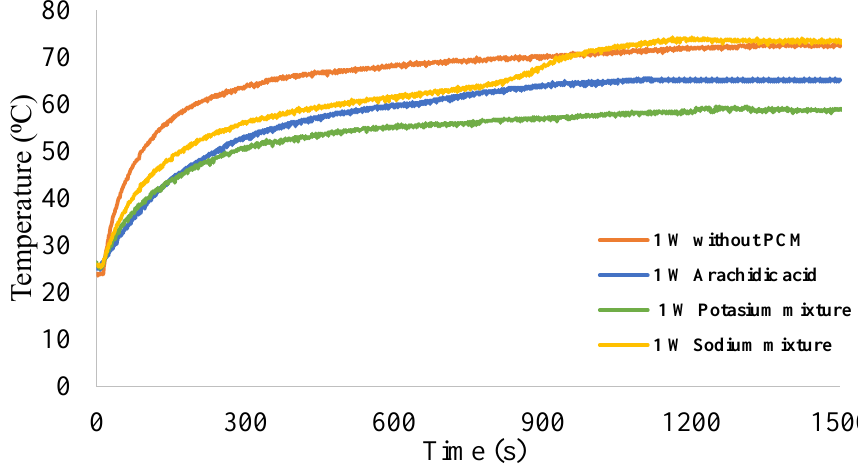
Figure 11. Temperature distribution for the heat sink without and with PCMs at 1 W. Finally, for the case 2 W, all PCMs melted, with differences in the peak temperatures and delay times. For the Arachidic acid, the peak temperature (104.5 °C) was lower than in the case without PCM (109 °C), with a time delay equal to 300 s. For the sodium mixture, the peak temperature (111 °C) was higher than in the case without PCM, with a delay equal to 900 s. The best results were obtained for the potassium mixture, which achieved the lowest peak temperature of 95.25 °C and the highest time delay of 1050 s. Figure 12. Temperature distribution for the heat sink without and with PCMs at 2 W.